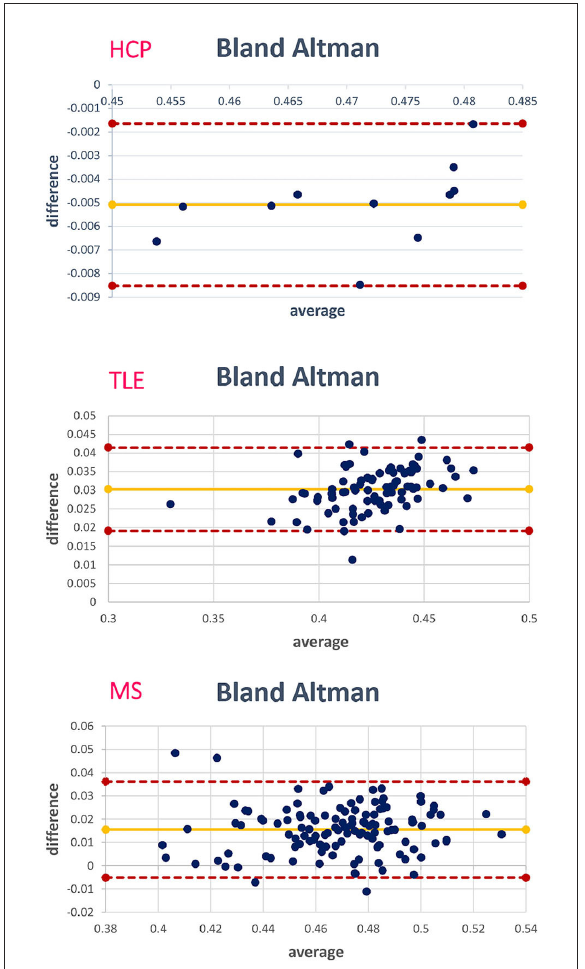
FIGURE10 For each data set, the corresponding Bland–Altman plot is shown; each blue dot corresponds to a subject. The yellow line indicates the mean of the difference between the white matter (WM) fractional anisotropy (FA) STANDARD method and NETWORK WM FA. The red lines indicate the limits of agreement (average difference ± 1.96 standard deviation of the